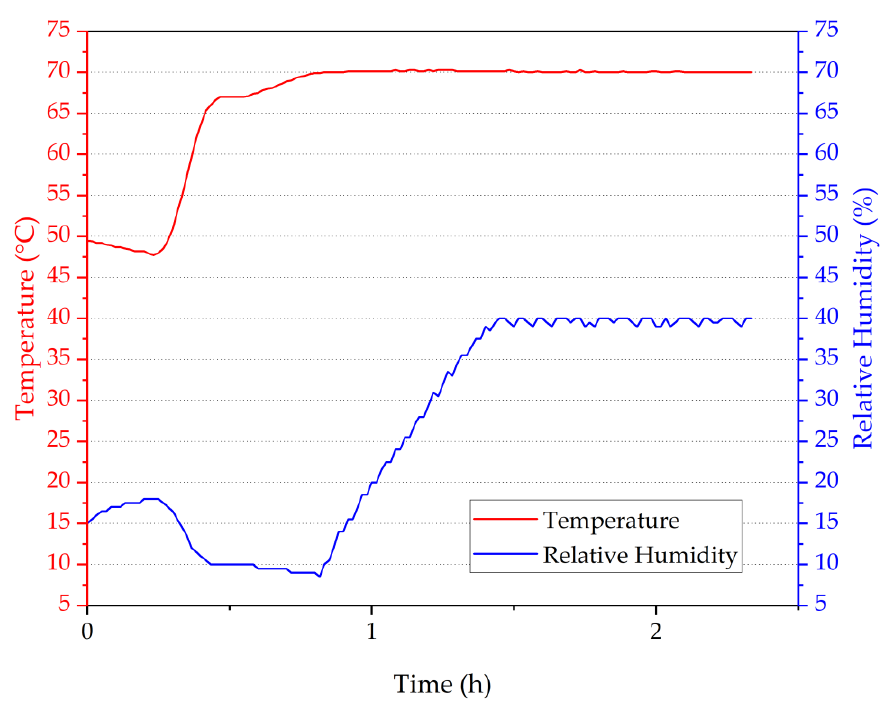
Figure 9. Temperature and humidity profile in the climatic chamber during thermal annealing.